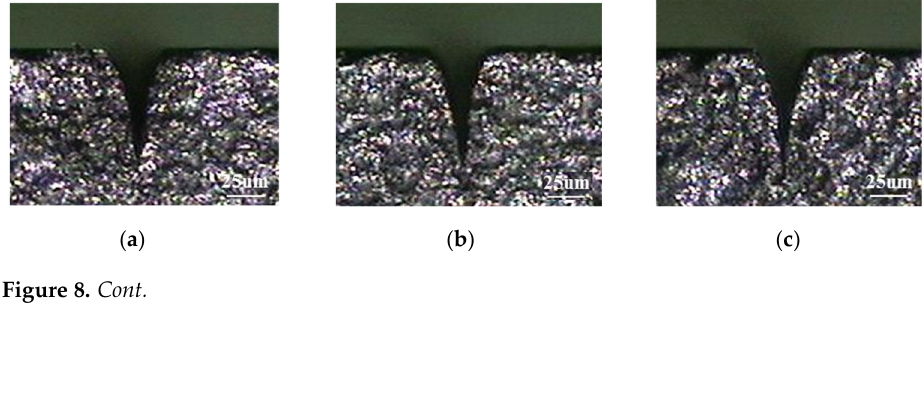
Figure 8. Optical microscope observation of the effect of variation in the number of cutting passes per path on the kerf depth in laser cutting of PCD workpiece (laser processing parameters were set at average power of 25.5 W, pulse width of 200 ns, and repetition rate of 170 kHz): ( a ) 1 pass per path; ( b ) 3 passes per path; ( c ) 5 passes per path; ( d ) 7 passes per path; ( e ) 9 passes per path. Figure 9. Relationship between number of cutting passes and kerf depth (laser processing parameters were set at average power of 25.5 W, pulse width of 200 ns, and repetition rate of 170 kHz). The effects of variation in pulse width and pulse energy of laser cutting on the PCD workpiece was studied at the fixed average power of 30 W. The lowest pulse repetition rate for a specific pulse width at which the maximum peak pulse power was obtained was selected, and the kerf depth and surface quality of the cut surface were discussed. In the laser cutting studies, the processing scan rate was set at 5 mm/s, and the number of cutting passes was set at one pass per path. The lowest pulse repetition rate corresponding to the specific pulse width, maximum pulse energy, and maximum peak power is listed in Table 5. The information in the table reveals that the lowest pulse repetition rate decreases corresponding to an increase in the pulse width under the constant average-power setting. Correspondingly, the pulse energy and peak power increase and decrease, respectively. Moreover, a large pulse width corresponded to an increased kerf depth, as depicted in Figure 10. Therefore, the maximum kerf depth corresponded to the pulse-width and pulse-repetition-rate values of 200 ns and 30 kHz, respectively. Furthermore, Figure 11 reveals that the kerf depth increased with an increase in pulse energy. Therefore, it can be inferred that conditions involving the maximum pulse width (200 ns) (at lowest pulse